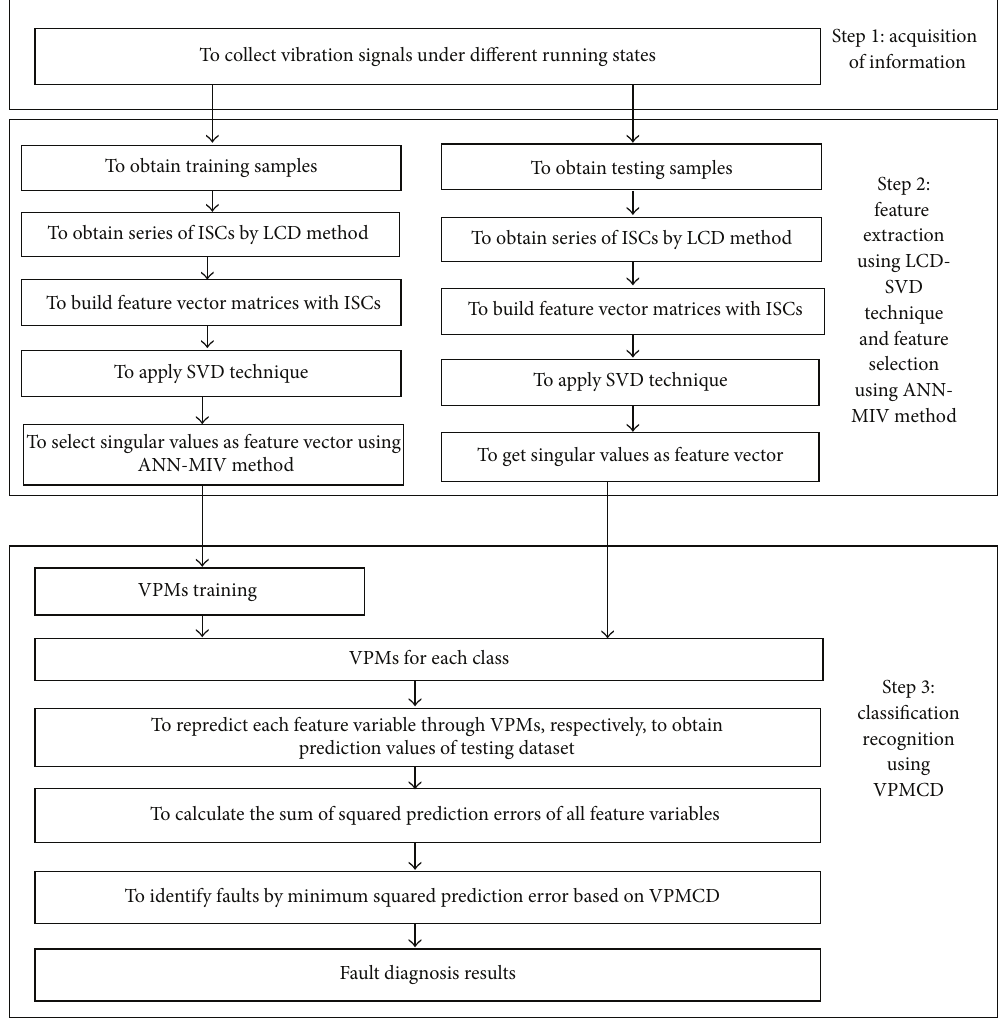
Figure 1: Fault diagnosis model for rotating machinery based on LCD-SVD-ANN-MIV and VPMCD.